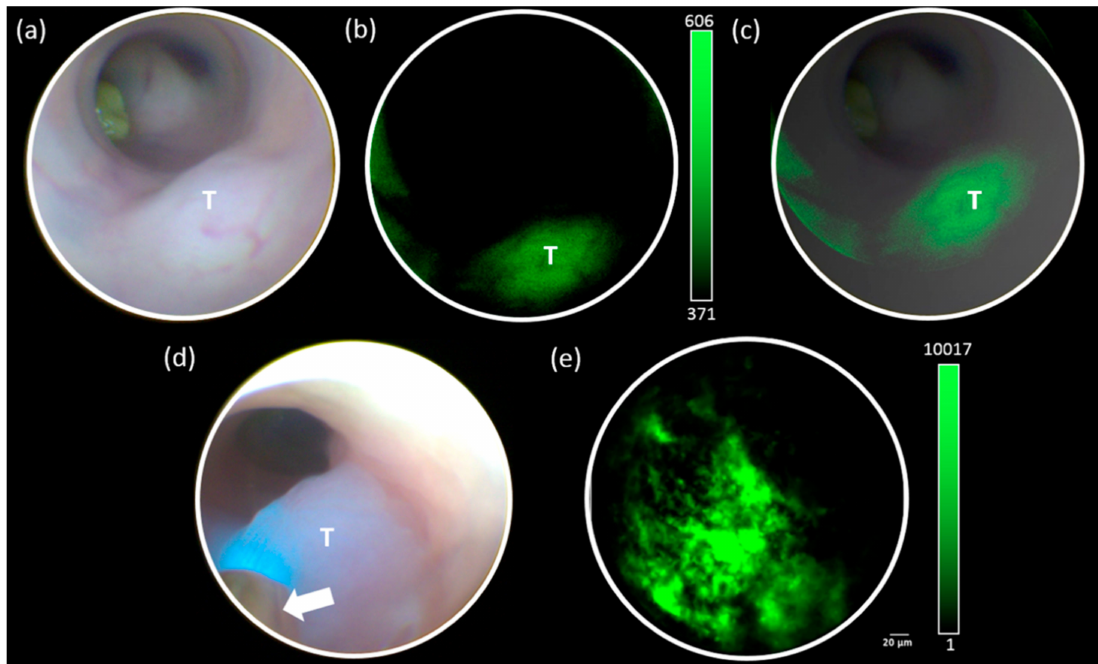
Figure 4. In vivo DSFE imaging of fluorescent bacteria in the orthotopic mouse colon tumor model. ( a )Whitelight, ( b )fluorescence, and( c )mergedimagesofthebacteriainjectedorthotopictumor(T)using the WFE system. ( d ) CFEM probe (white arrow) contacted the tumor (T) lesion. ( e ) Bacteria-emitting fluorescence signal imaged using the CFEM